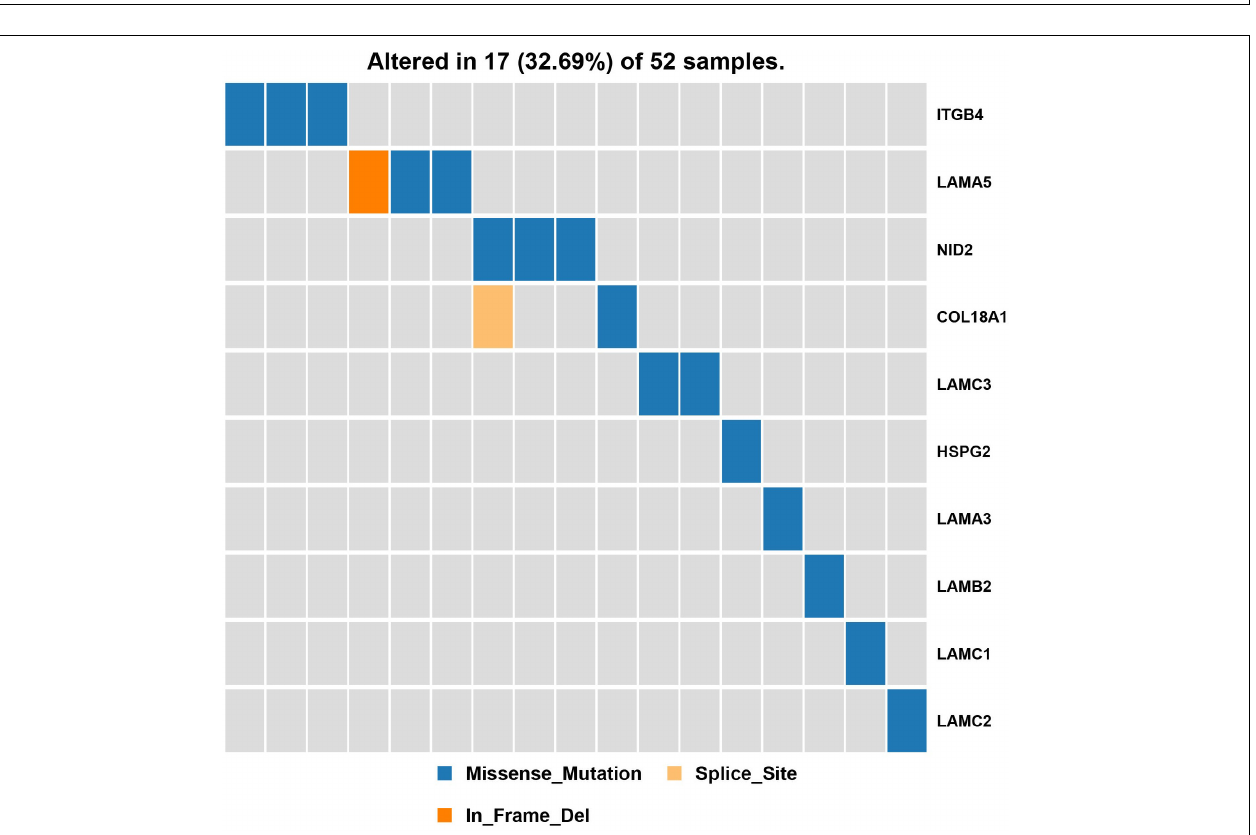
FIGURE 4 | Results of the ConsensusPathDB enrichment analysis of genes found to be mutated in > 2 patients with hemifacial microsomia (HFM).